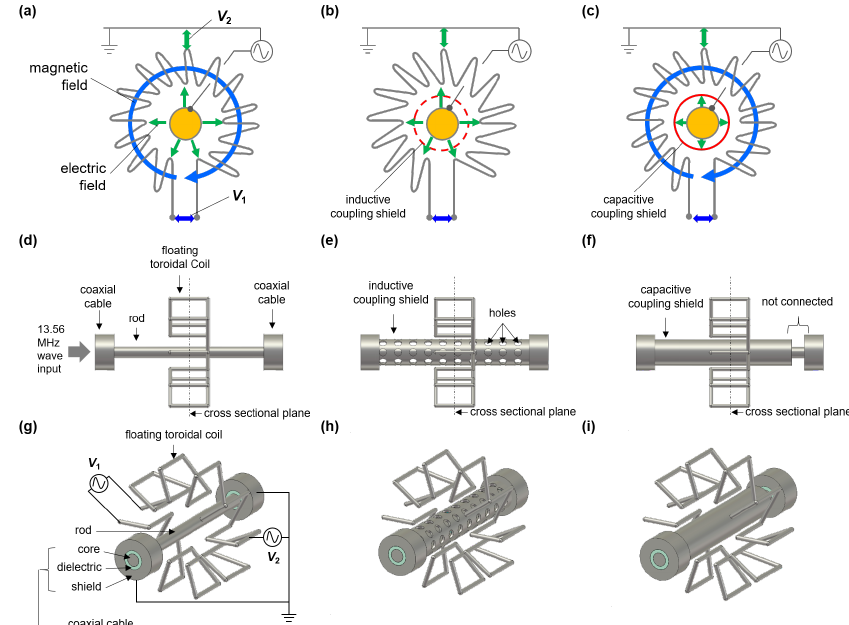
Figure 2. ( a – c ) Schematic diagrams of the simulation configurations and ( d – i ) corresponding three- dimensional images. Capacitive and inductive coupling is present in ( a , d , g ); only capacitive coupling is present in ( b , e , h ); and only inductive coupling is present in ( c , f , i ). Here, V 1 means the voltage difference between the ends of the floating toroidal coil, and V 2 is the voltage difference between the center of the coil and the grounded